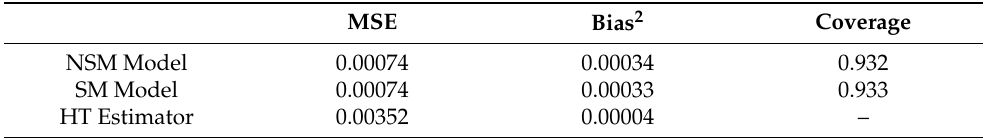
Table 2. Collapsed multinomial simulation MSE, squared bias, and 95% credible interval coverage rate. The results are averaged across 49 geographic areas and four categories. Simulated data are based on Week 1 of the Household Pulse